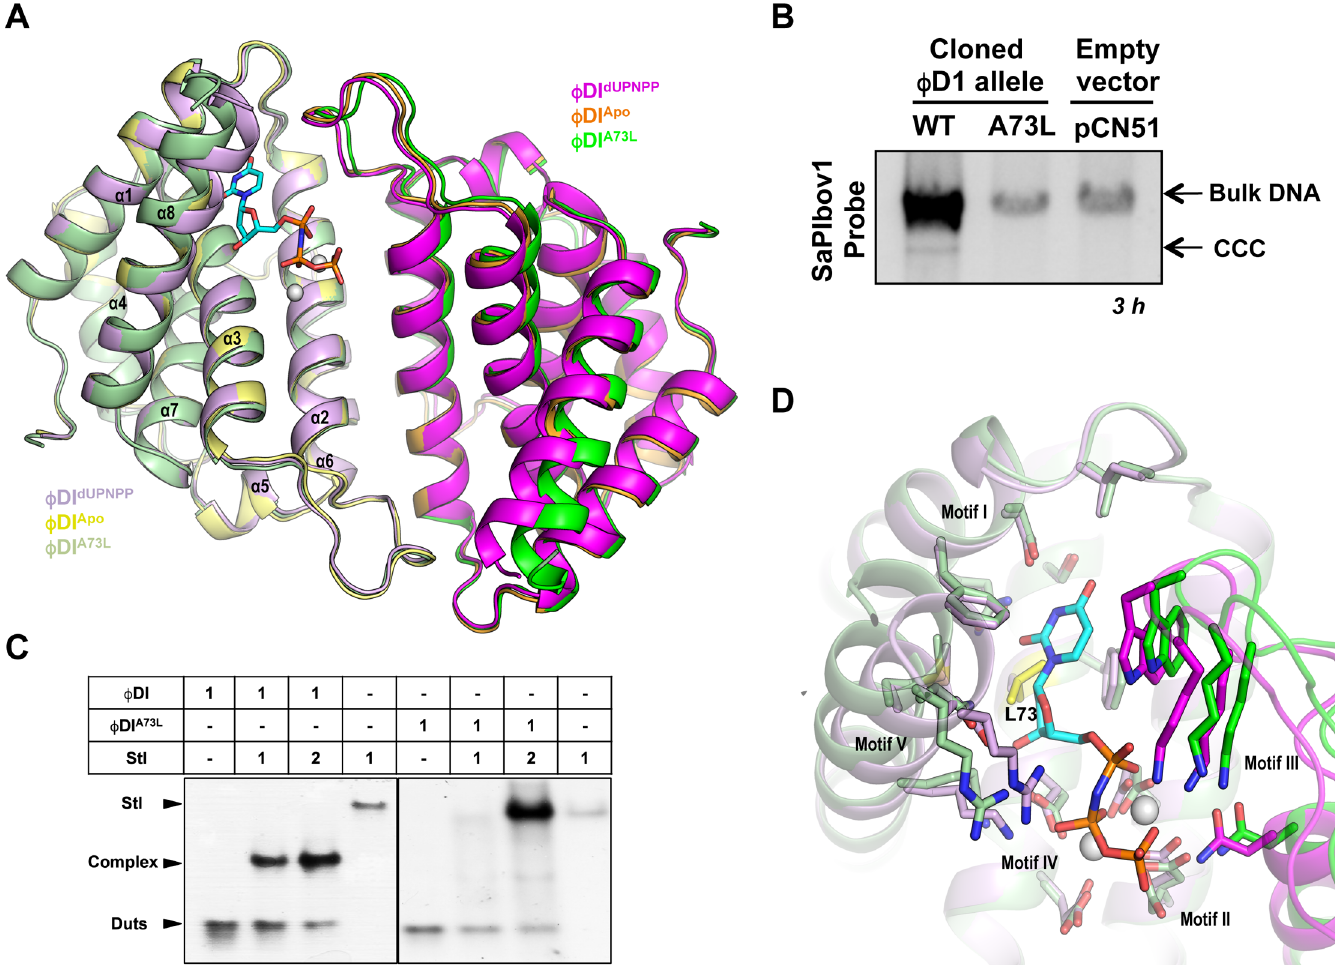
Fig 6. Structures of ϕ DI apo and ϕ DI A73L dimeric Duts showed minimal conformational changes in the mutant, but a high impact on SaPI induction and Stl interaction. (A) Superimposition of three-dimensionalstructures of the ϕ DI dimer in apo form (yellowtones), dUPNPP bound(magenta tones) and as A73L mutant (green tones) in cartoon representation. The nucleotide in the ϕ DI-dUPNPP structure is represented in stick with carbon atoms in cyan and Mg as green spheres. (B) SaPIbov1 excisionand replication followinginductionof the cloned ϕ DI A73L dut gene. Strain JP6774containing SaPIbov1 was complemented with plasmidsexpressingthe 3xFLAG-tagged ϕ DI and ϕ DI A73L dimeric Dut or the empty pCN51 plasmidas a control. Samples were isolated at 3 hours after inductionwith 3 μ M CdCl 2 and Southern blots were performed using a probe for the SaPIbov1 integrase(S4 Table). The upper band is ‘bulk’DNA, includingchromosomal, phage, and replicating SaPI. CCC indicates covalentlyclosed circularSaPI DNA. In these experiments, as no helper phagewas present, the excisedand replicatingSaPI DNA appearsas part of the bulk DNA or as CCC molecules,rather than the linear monomers that are seen followinghelperphage-mediated inductionand packaging. (C) Native-PAGE experiment was performed to analyze the bindingcapacity of the ϕ DI A73L Dut vs the ϕ DI wild-typeform. Proteinswere mixed with Stl in equimolecular relationship (in monomers). A clear reductionin the band corresponding to the Stl- ϕ DIDut A73L complex with respect to the Stl- ϕ DI Dut complex is observed. (D) Close-upview of the superimposed ϕ DI- dUPNPP and ϕ DI A73L active centers. Residuesresponsible for substrate coordinationand bindingare representedin sticks with carbon atoms colored accordingto the structure to which they correspond. The Leu73 residueat the bottom of the active center of the ϕ DI A73L mutant that precludesthe bindingof the nucleotideis colored in yellow. The substrate dUPNPP in the ϕ DI-dUPNPP structure is representedin stick with carbonatoms in cyan and Mg ions are representedas grey